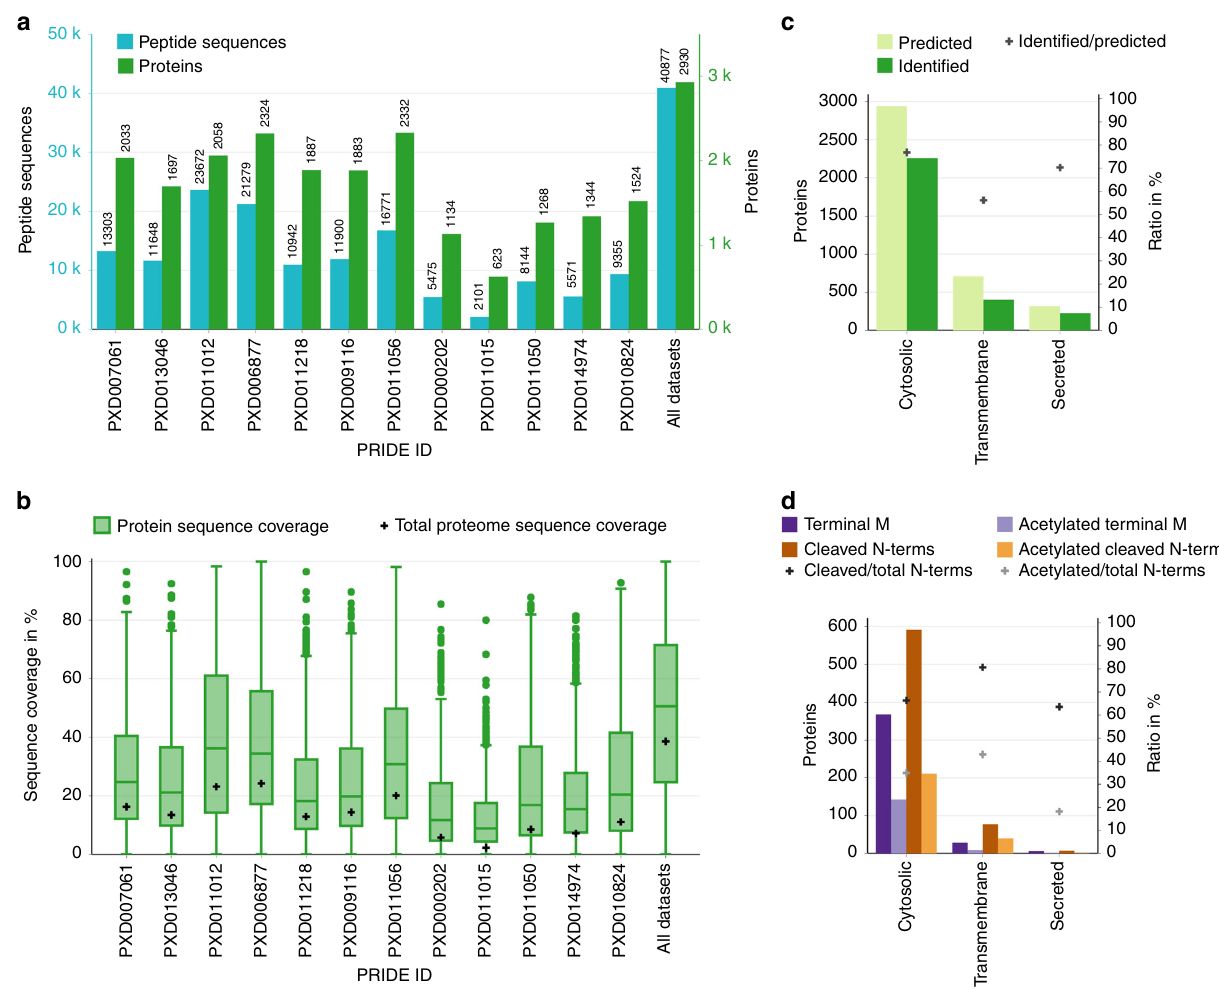
Fig. 3 Highly con fi dent identi fi cation of 2930 proteins with a median sequence coverage of 51%. a The number of identi fi ed peptide sequences (blue) and proteins (green), with a peptide FDR ≤ 1% and protein FDR ≤ 0.5%, respectively, as well as at least two PSMs, is given for each dataset as well as the combination of all datasets. b Box-plots for the sequence coverage of all con fi dently identi fi ed proteins (green, number of proteins for each dataset is given in Fig. 3a) as well as the total proteome sequence coverage (black crosses) is given for each dataset and the combination of all datasets (center